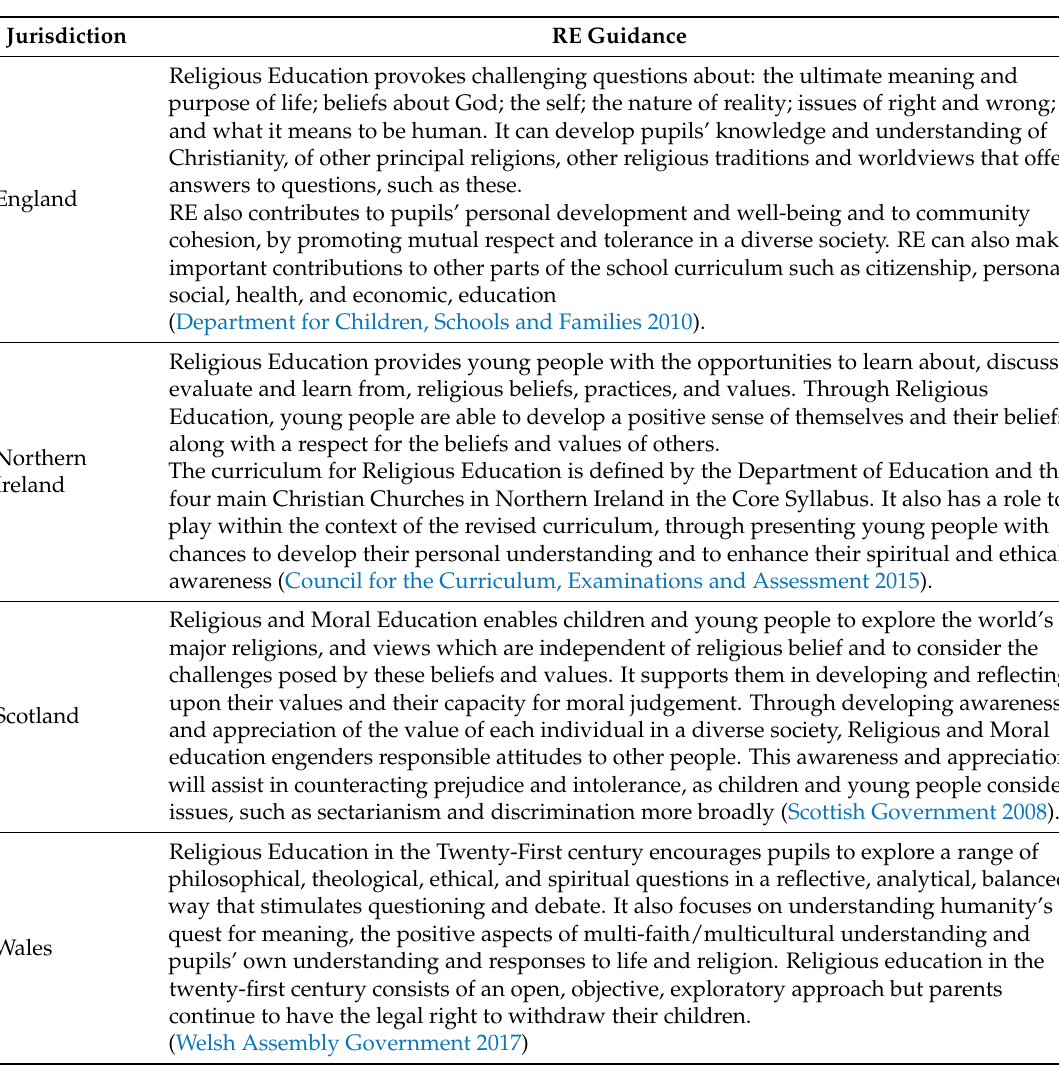
Table 1. UK Religious Education Government